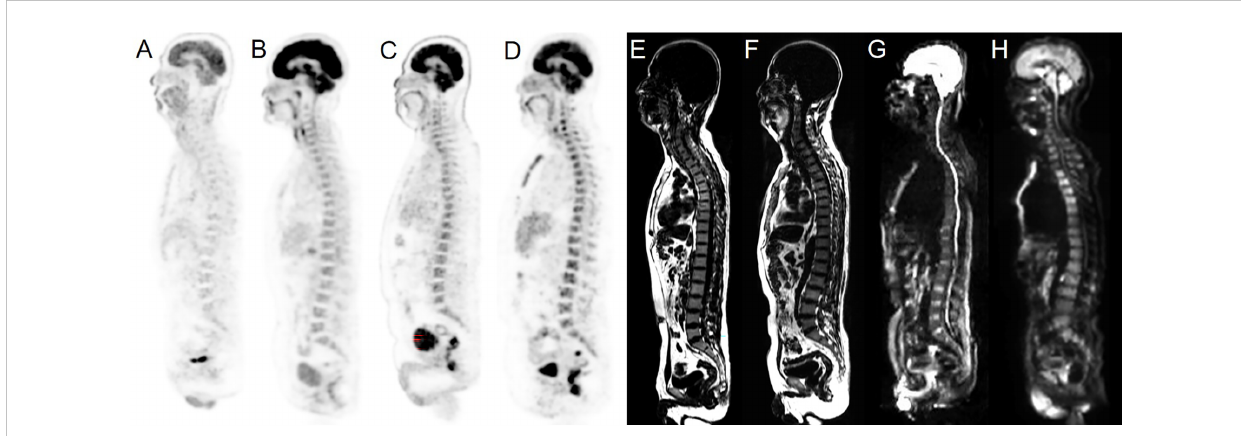
FIGURE 1 Examples of normal BMs and BMI in our cohort. Sagittal PET images derived from integrated PET/MRI (A – D) , T1WI and sagittal DWI images derived from integrated PET/MRI (E – H) . Normal (A) and homogeneously increased 18 F-FDG uptake above the liver parenchyma (B) were considered PET- negative. Heterogeneously increased (C) and unifocal/multifocal FDG uptake above the liver parenchyma uptake (D) were considered PET-positive. Normal signals of BM on the sagittal T1WI image were considered MRI-negative (E) . T1WI positivity was de fi ned as decreased signal intensity compared to the surrounding muscles (F) . Normal signals of BM on the sagittal DWI image were considered MRI-negative (G) . DWI positivity was de fi ned as increased signal intensity compared to the surrounding muscles and intervertebral discs (H)